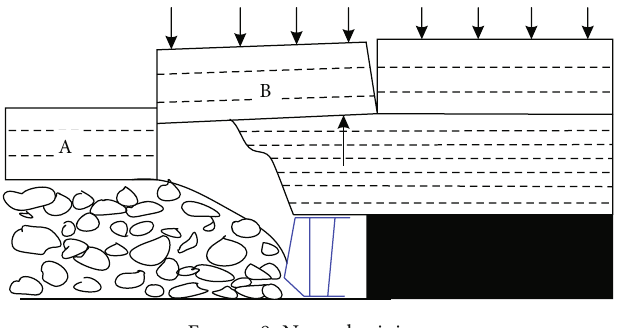
Figure 8: Normal mining.